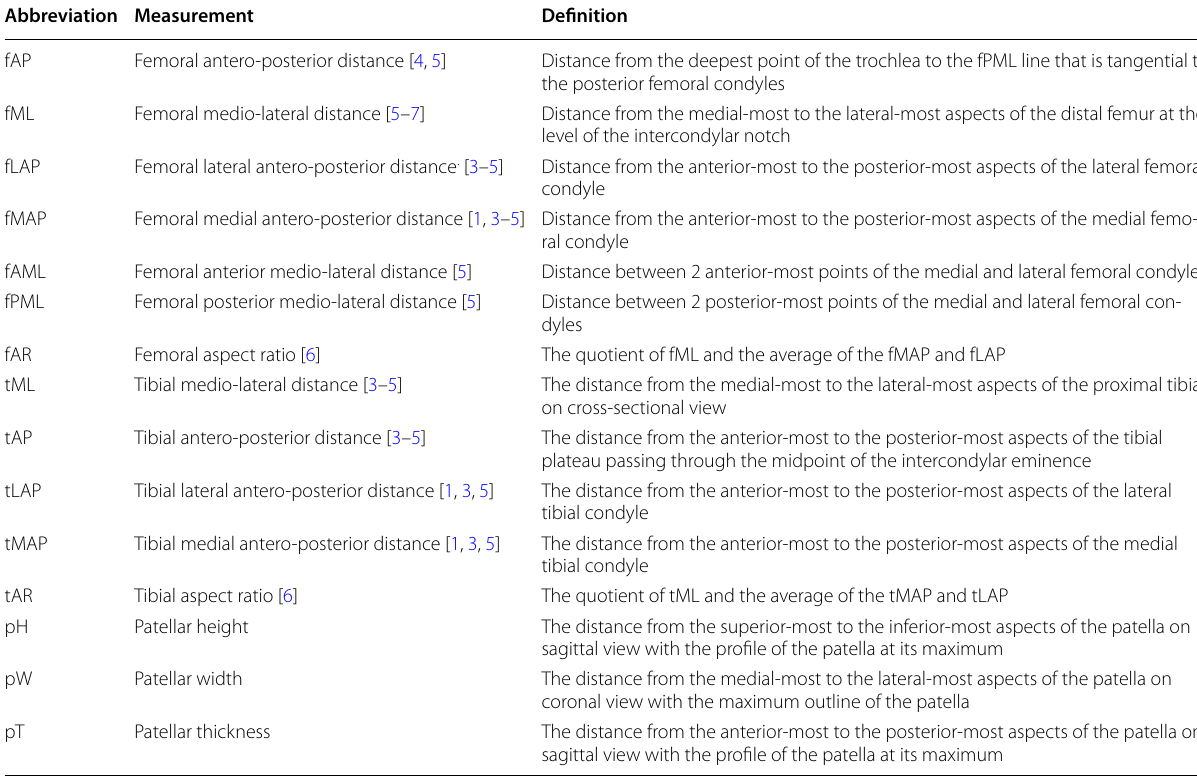
Table 1 The morphometric parameters of distal femur, proximal tibia and the patella Abbreviation